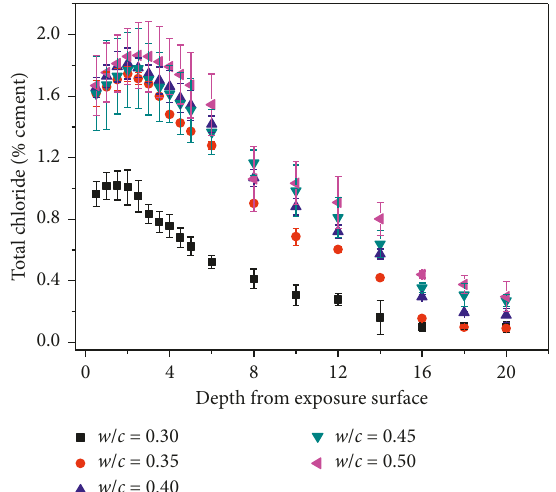
Figure 4: Total chloride profiles of paste specimens with different w / c . Table 3: Surface chloride content ( C efficient ( D ), and correlation coefficient ( R 2